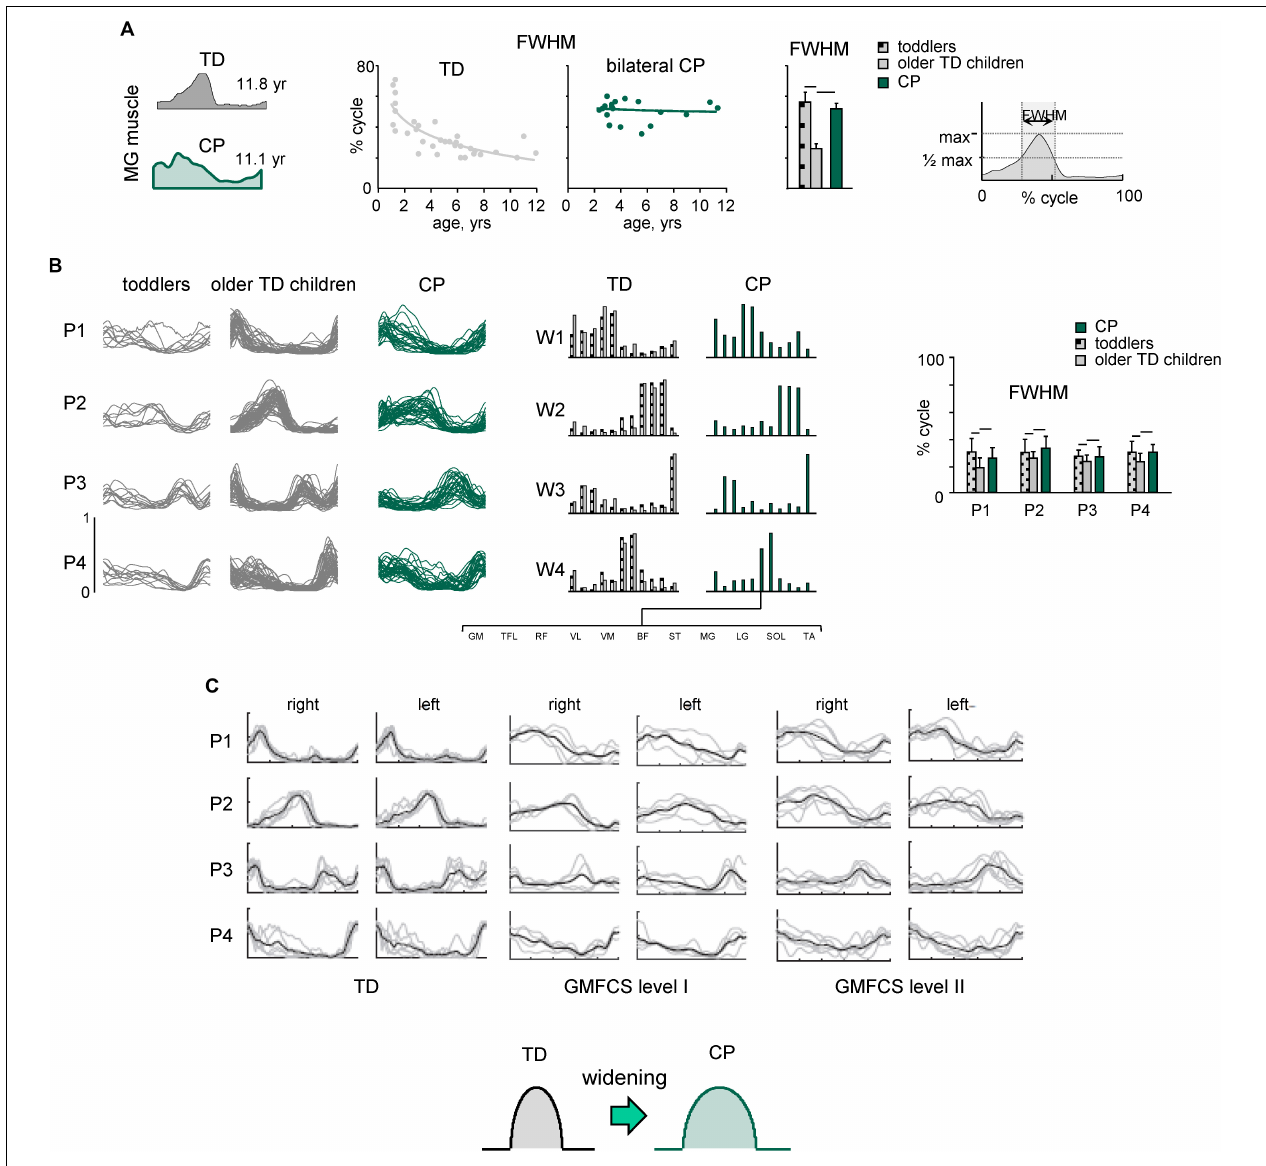
FIGURE 3 | Spatiotemporal organization of muscle activity patterns during walking. (A) Developmental trend for the duration of muscle (MG, medial gastrocnemius) activity. From left to right: examples of MG activity in one TD child and one child with bilateral CP, duration of MG activity (FWHM, full width at half maximum, see right panel) as a function of age (continuous lines represent exponential fittings), and averaged across children [horizontal lines denote significant differences compared with older TD children (2–12 years)]. (B) Statistical analysis of EMG patterns: basic activation patterns P1–P4 (each curve represents the pattern for an individual child) and corresponding weights W1–W4 (muscle synergies). Right panel – mean (+SD) FWHM of consistent basic activation patterns (P1–P4). Adapted from Cappellini et al. (2016). (C) Basic activation patterns (for the right and left sides) in TD children and children with bilateral CP at Gross Motor Function Classification System (GMFCS) levels I and II (adapted from Yu et al., 2019 with permission). Note significantly wider patterns in CP, independent of GMFCS